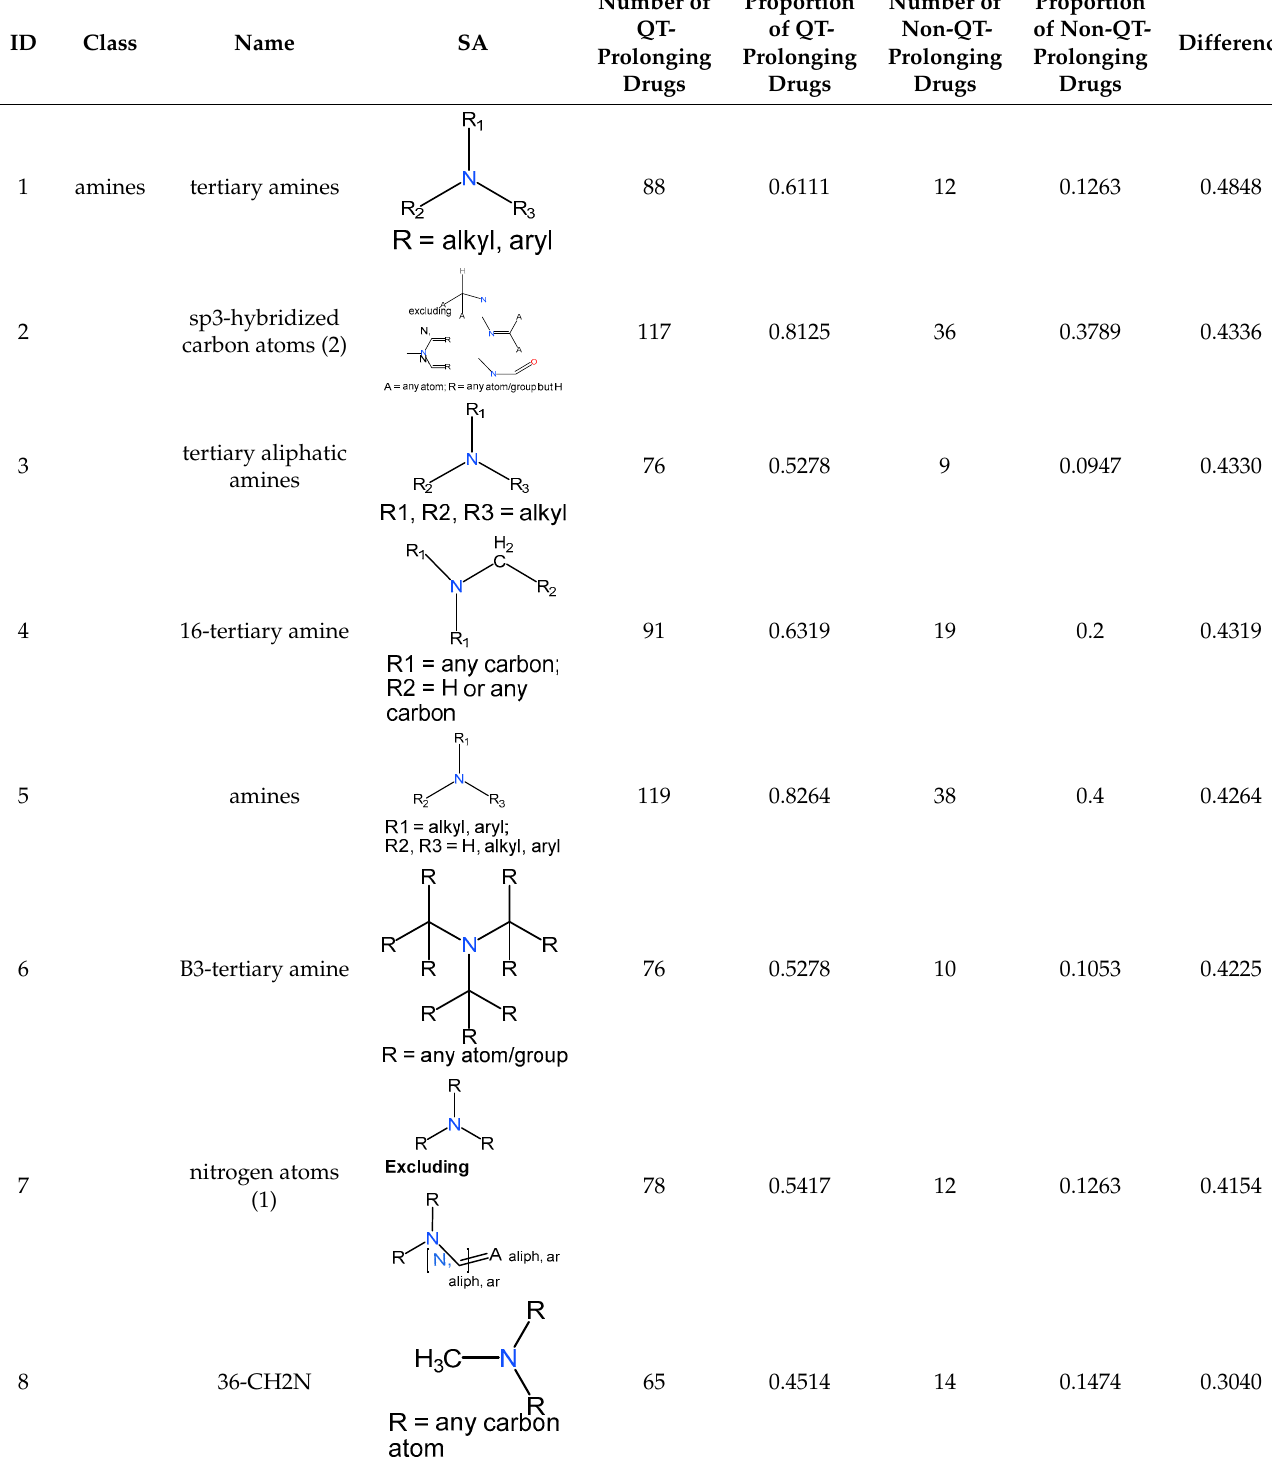
Table 1. Twenty-four chemical fragments (SAs) with large differences in chemical structures between QT-prolonging drugs and no-DIQT-concern drugs.